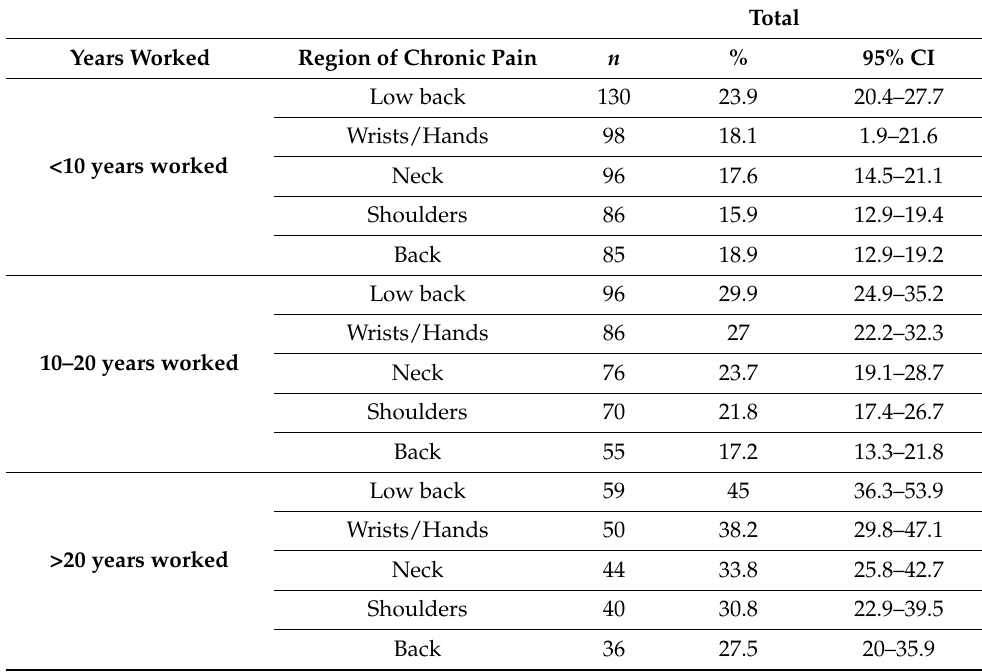
Table 2. Bivariate analysis of chronic pain by body regions and years worked ( n = 1019).